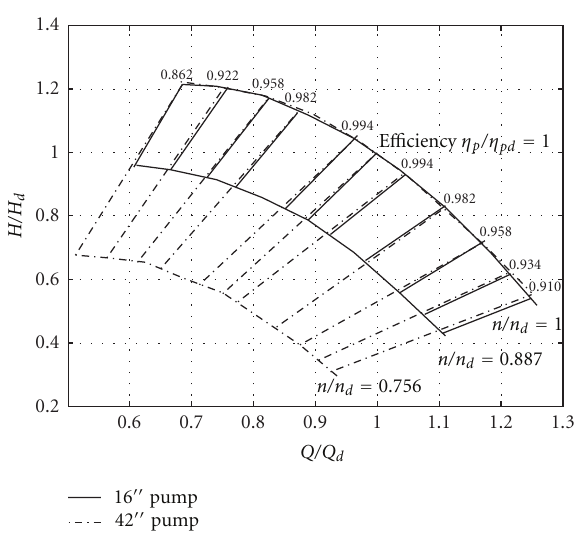
Figure 4: Comparison between performance maps of two di ff erent mixed-flow